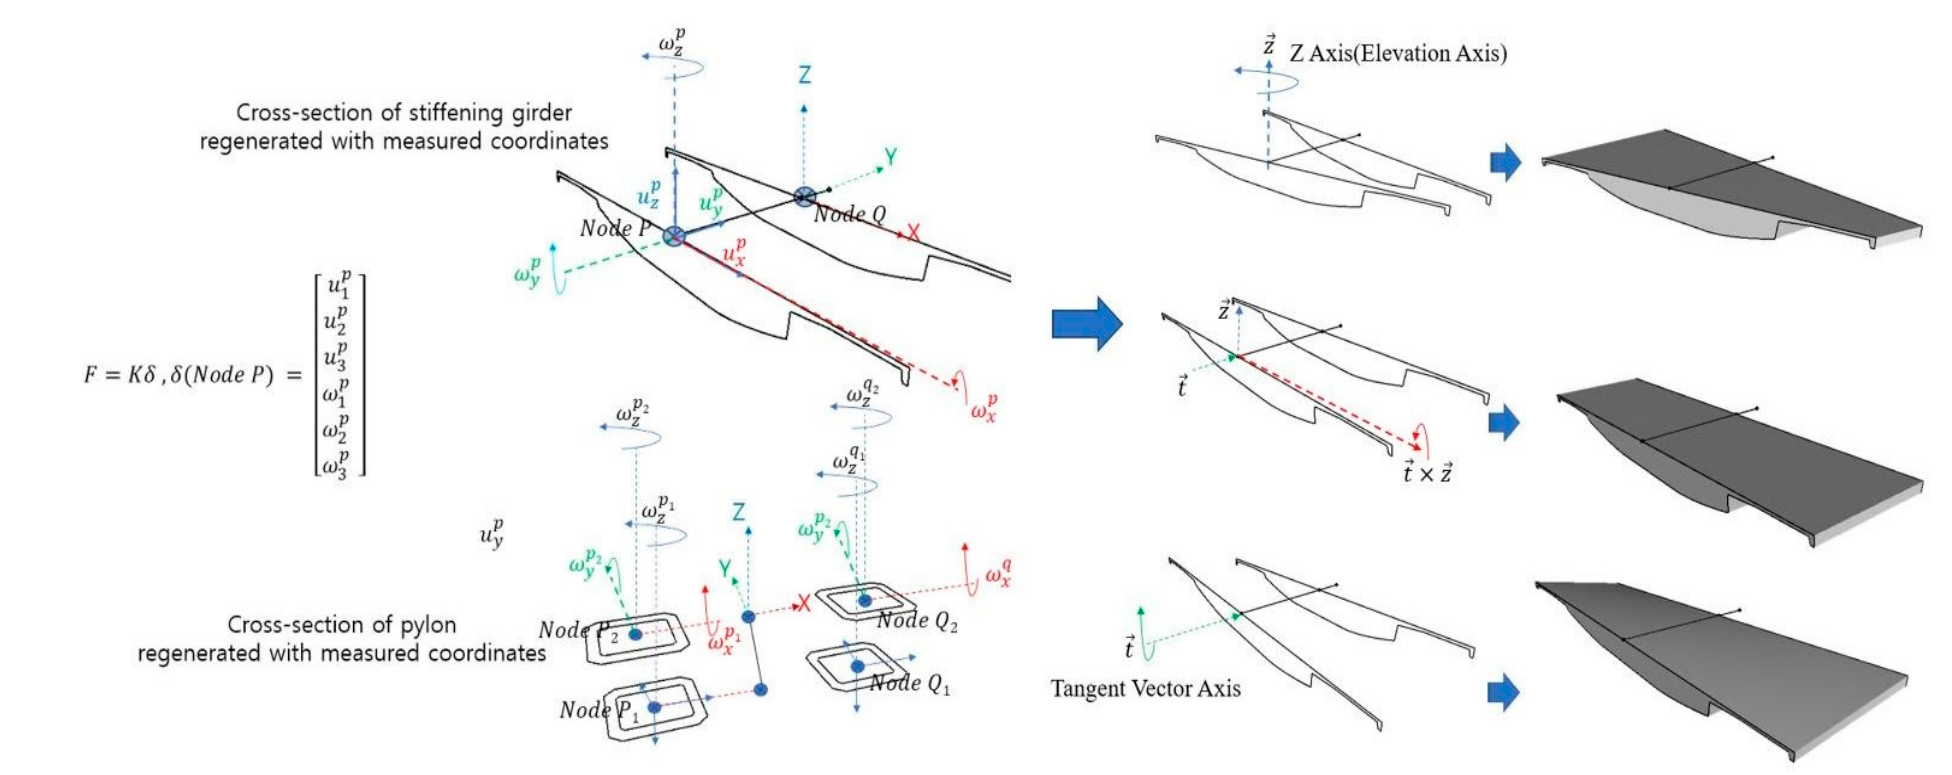
Figure 11. Model revision according to deformation of each location.